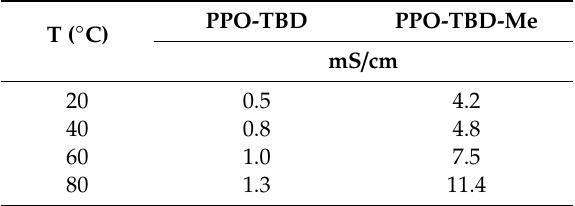
Table 2. Ionic conductivity of PPO-TBD and PPO-TBD-Me (Cl − form) in fully humidified conditions. T ( ◦